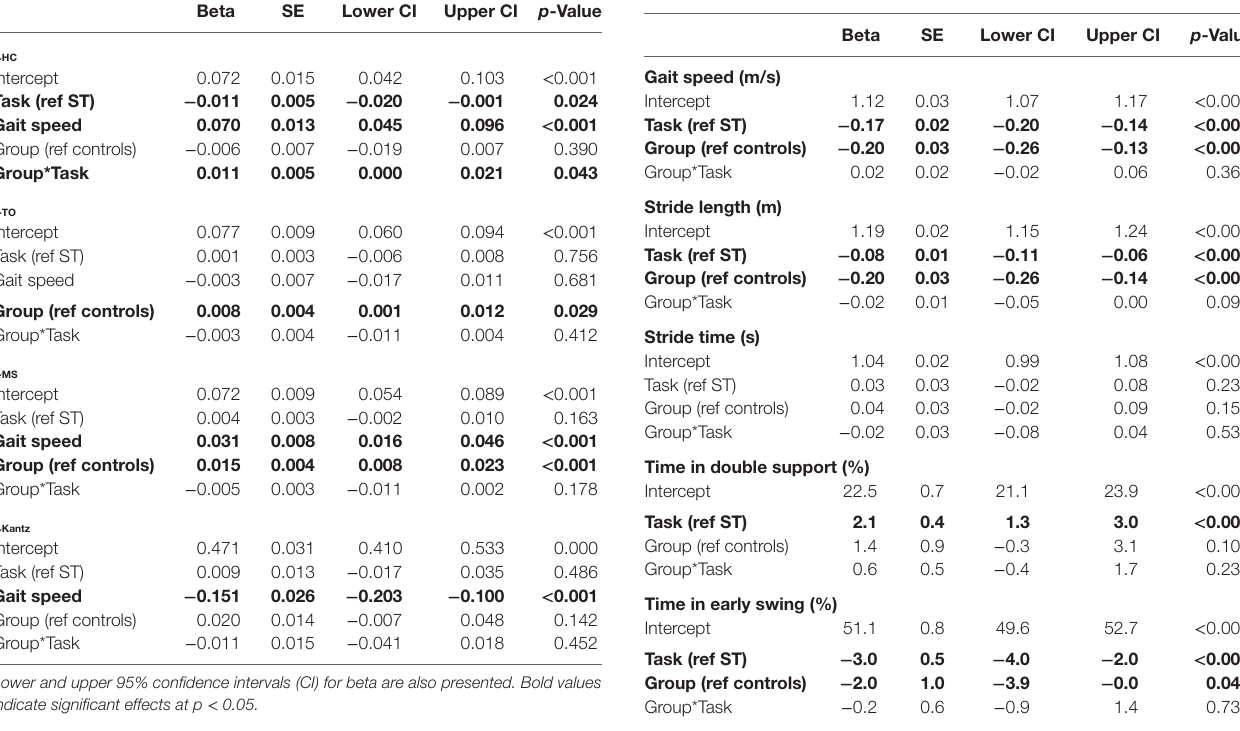
Table 4 | Results from the linear mixed models for each spatiotemporal measure.